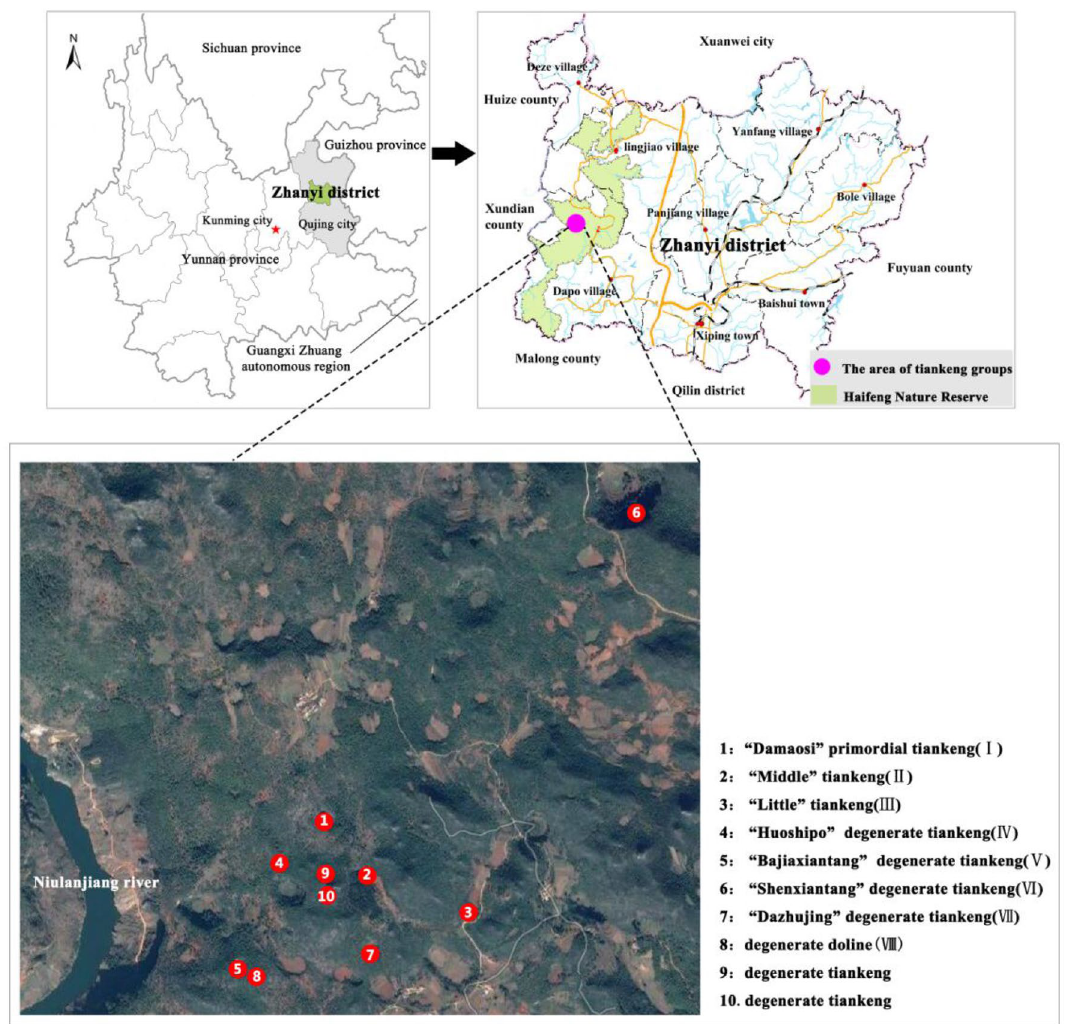
Figure 6. Location of Zhanyi karst tiankeng group in Yunnan Province. The map at the top is from the ArcGIS 10.2 software (https:// www. esri. com) by vector processing based on the administrative map. The map below is from remote sensing image obtained by United States Geological Survey (USGU, https:// www. usgs. gov/), and preprocessed by ENVI 5.0 software (http:// www. harri sgeos patial. com). These maps were merged by the Photoshop CS6 software (http:// www. adobe. com) and marked the names of these tiankengs.